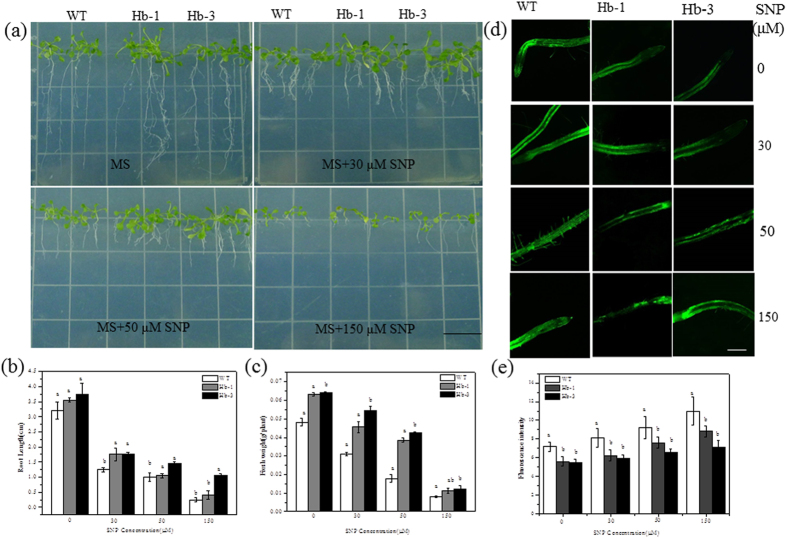
Effect of excess SNP on the growth of SoHb transgenic Arabidopsis for 7 days.Seedling morphology (a), root length (b), fresh weight (c) of the WT and transgenic lines grown on MS supplemented with 0, 30, 50, and 150 μM SNP. Bars = 1 cm. (d) The NO content of WT and transgenic plants under excess NO stress treatment. WT was wild type Columbia Arabidopsis; Hb-1 and Hb-3 were two homozygous transgenic Arabidopsis lines. (e) Average fluorescence intensity levels of root tips of WT and transgenic lines grown under different concentration of SNP. The experiment was replicated three times with similar results. Bars = 100 μM.